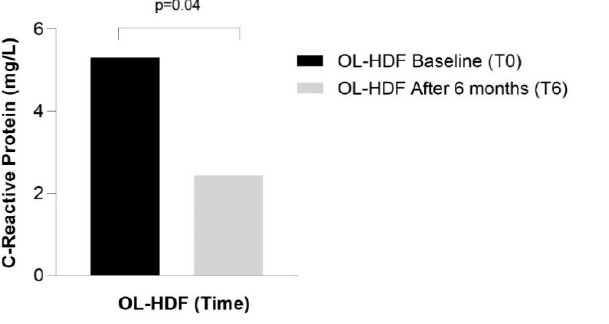
Figure 3. Alkaline phosphatase serum concentration in patients who showed a reduction in the serum concentration of Indoxyl Sulfate over 6 months of online hemodiafiltration (OL-HDF).